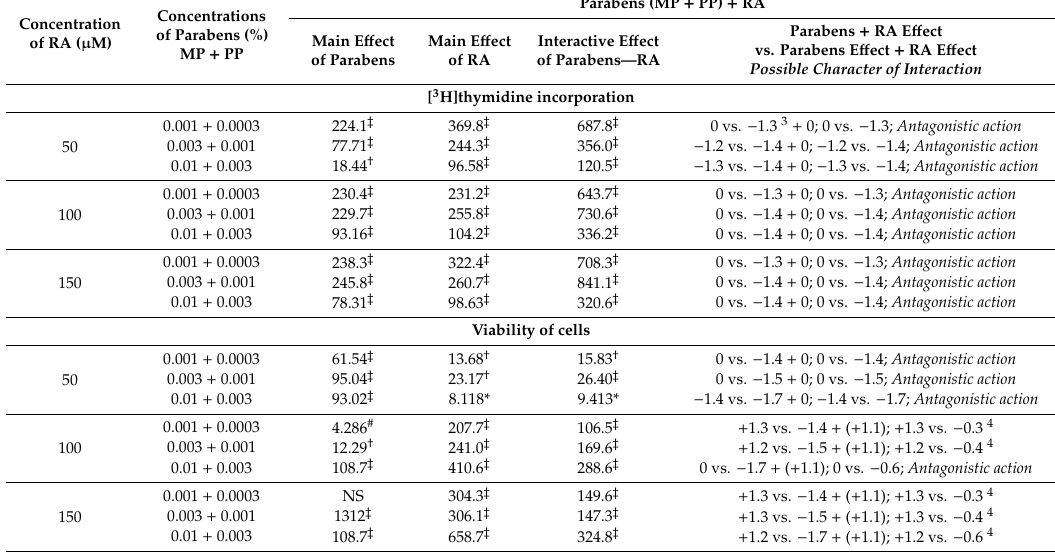
Table 3. Estimation of the main and interactive e ff ects of parabens (methylparaben—MP and propylparaben—PP) and rosmarinic acid (RA) on the proliferation, based on [ 3 H]thymidine incorporation into deoxyribonucleic acid (DNA), and the viability of the human skin fibroblasts 1, 2 . Concentration of RA ( µ